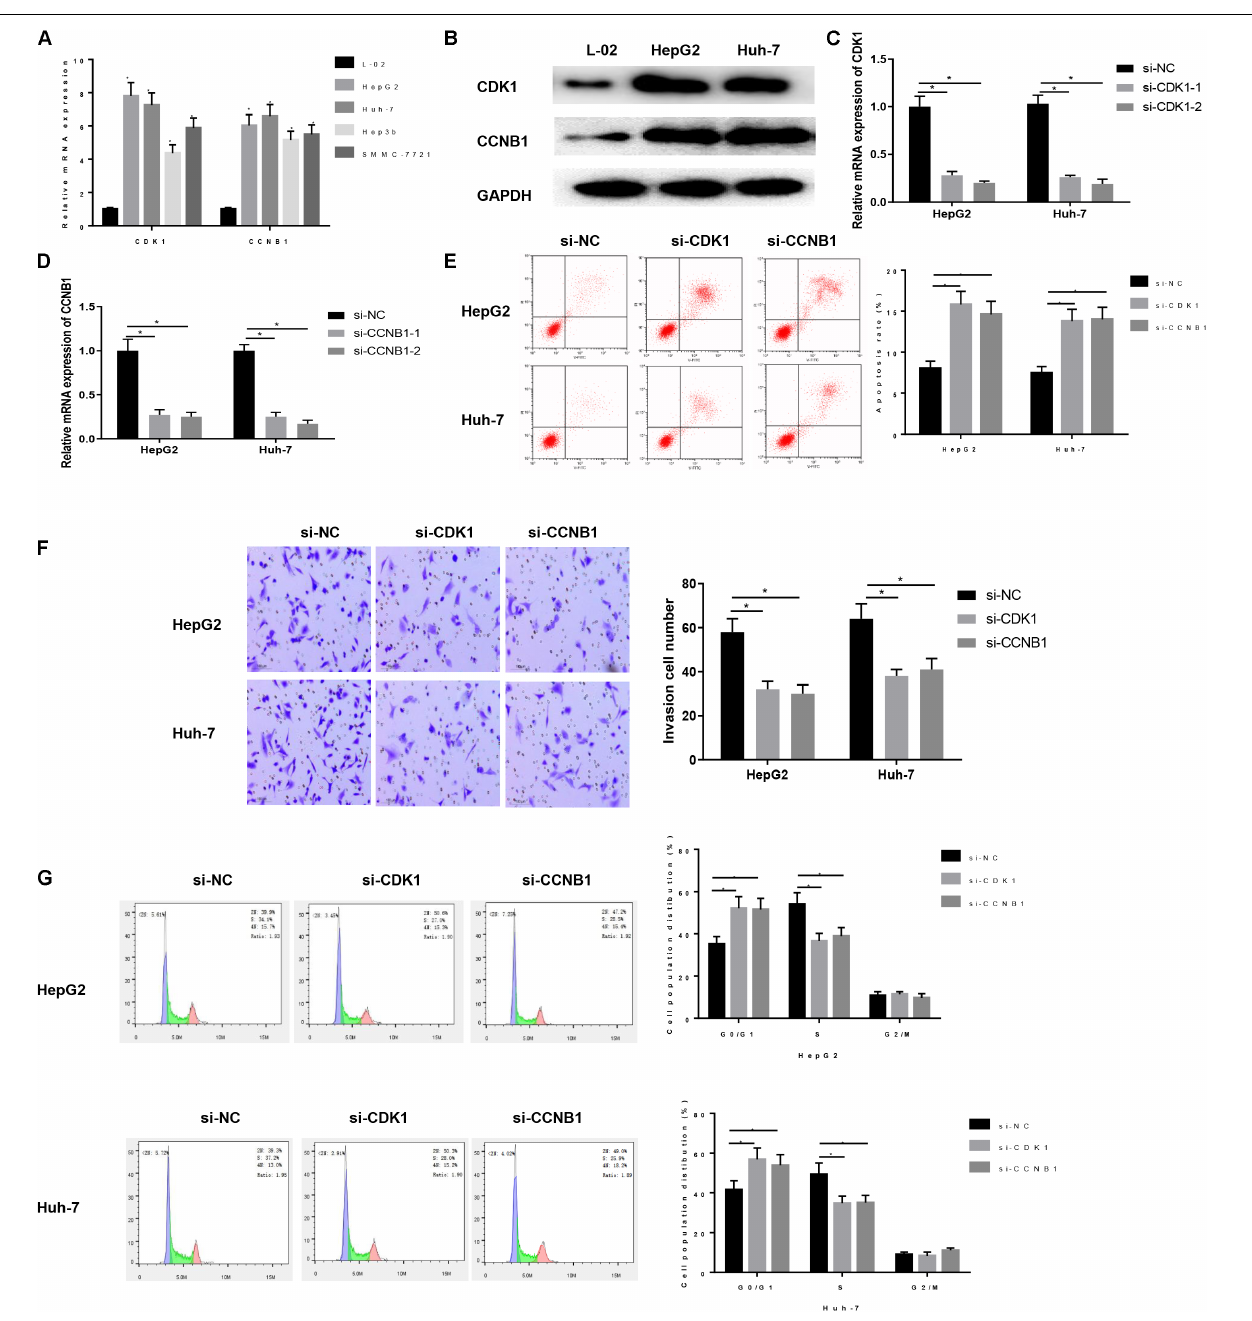
FIGURE 2 | Expression and regulation of CDK1 and CCNB1 in HCC cells. (A) The expressions of CDK1 and CCNB1 in normal human cells and four HCC cell lines were detected by qRT-PCR; (B) The protein expressions of CDK1 and CCNB1 in HepG2 and Huh-7 were detected by WB; (C,D) The silencing efficiency of CDK1 and CCNB1 was measured by qRT-PCR; Cells development in each group was detected by FCM and Transwell assays (100 × ). (E) Cell apoptosis; (F) Cell invasion; (G) Cell cycle. *means P < 0.05. Representative of three independent experiments.